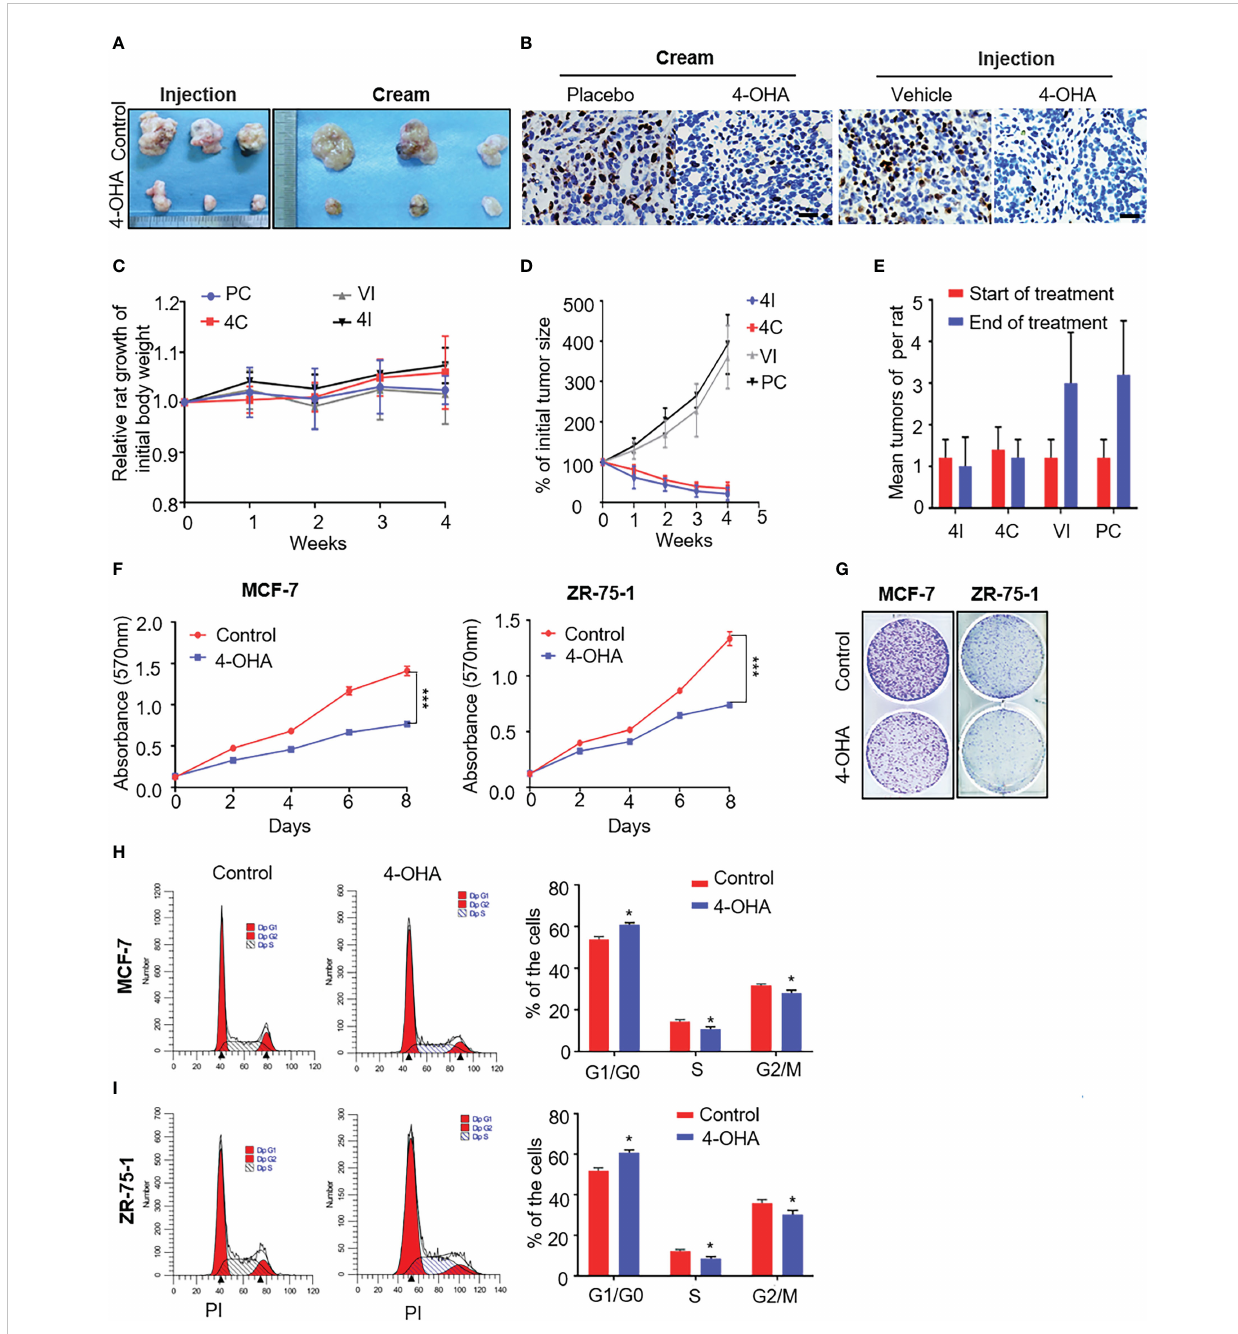
FIGURE 2 The effects of 4-OHA cream on breast cancer growth. At an age of 50 – 54 days, female Sprague-Dawley rats were dosed intragastrically with 20 mg DMBA. Animals were selected for experiments when at least one tumor per rat had reached a diameter of 1.5 cm but less than 2 cm. The skin covering the tumor was shaved and the animals were divided into four groups. In 4-OHA and placebo cream groups, tumors were treated by direct application of the cream. (A – E) Tumors in the 4-OHA injection group were treated with twice-daily s.c. injections of 1 ml/kg of 4-OHA (50 mg/kg/ day), and control animals received injections of the 4-OHA-suspending vehicle (peanut oil) at the same time. (A) Representative images of the tumors. (B) Expression of the proliferation marker Ki67 in tumor tissues was measured by immunohistochemistry. Scale bar, 20 m m. (C) Rat weight evolution during the experiment. The values are expressed as the mean. (D) Tumor growth curve. Average number of tumor nodules before and after treatment. (E) The data represent six sets of independent experiments and are shown as the means ± SD. *p < 0.05 vs. control group. The effects of 4-OHA on the growth of the cells. (F – I) Cells were cultured in 10% PRF-CT with E2 1 nM for 3 days before the experiment. (F, G) Cells were seeded in 96-well or six-well plates and 24 h later they were exposed to 1 m M of 4-OHA for 8 days. MTT (F) and Colony formation (G) assay were performed. Analysis of the cell cycle of MCF-7 (H) and ZR-75-1 (I) by fl ow cytometry as described in the Materials and Methods. Data represent a mean ± SEM of three independent experiments, each in triplicate; bars, SEM. *p ≤ 0.05 vs. control. control. PC, Placebo cream; 4C, 4- OHA cream; VI, vehicle; 4I, 4-OHA